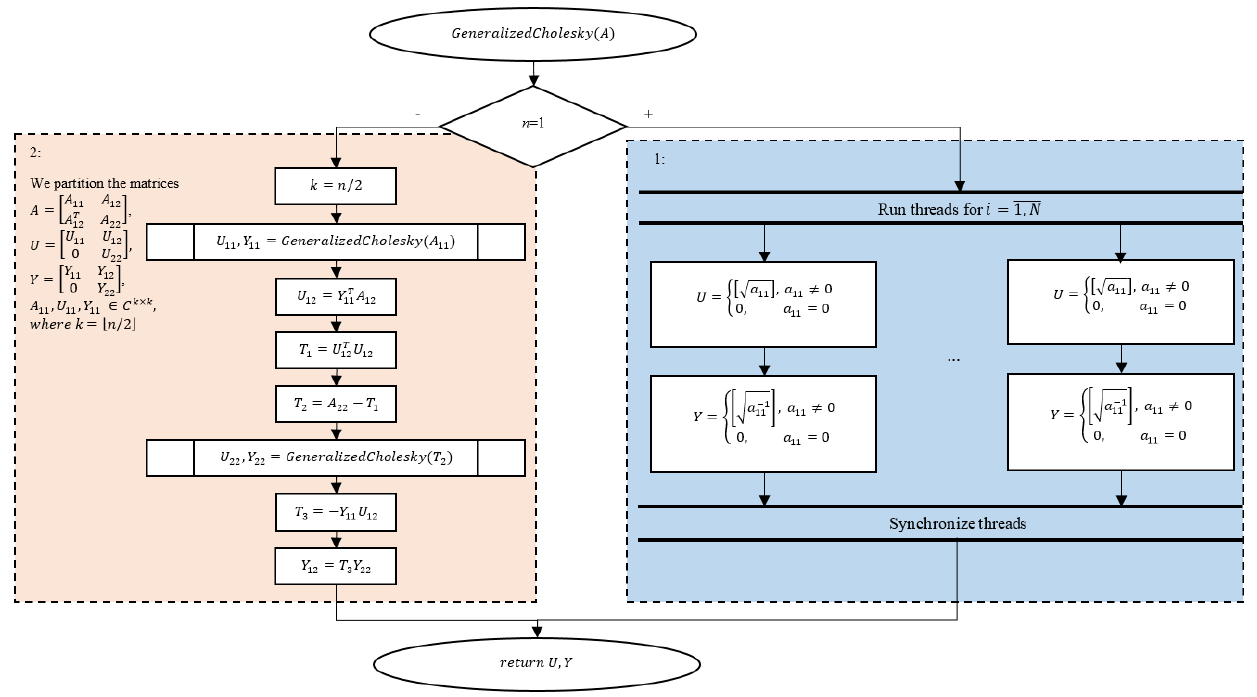
Figure 5. Step 1 of Cholesky factorization for CUDA.